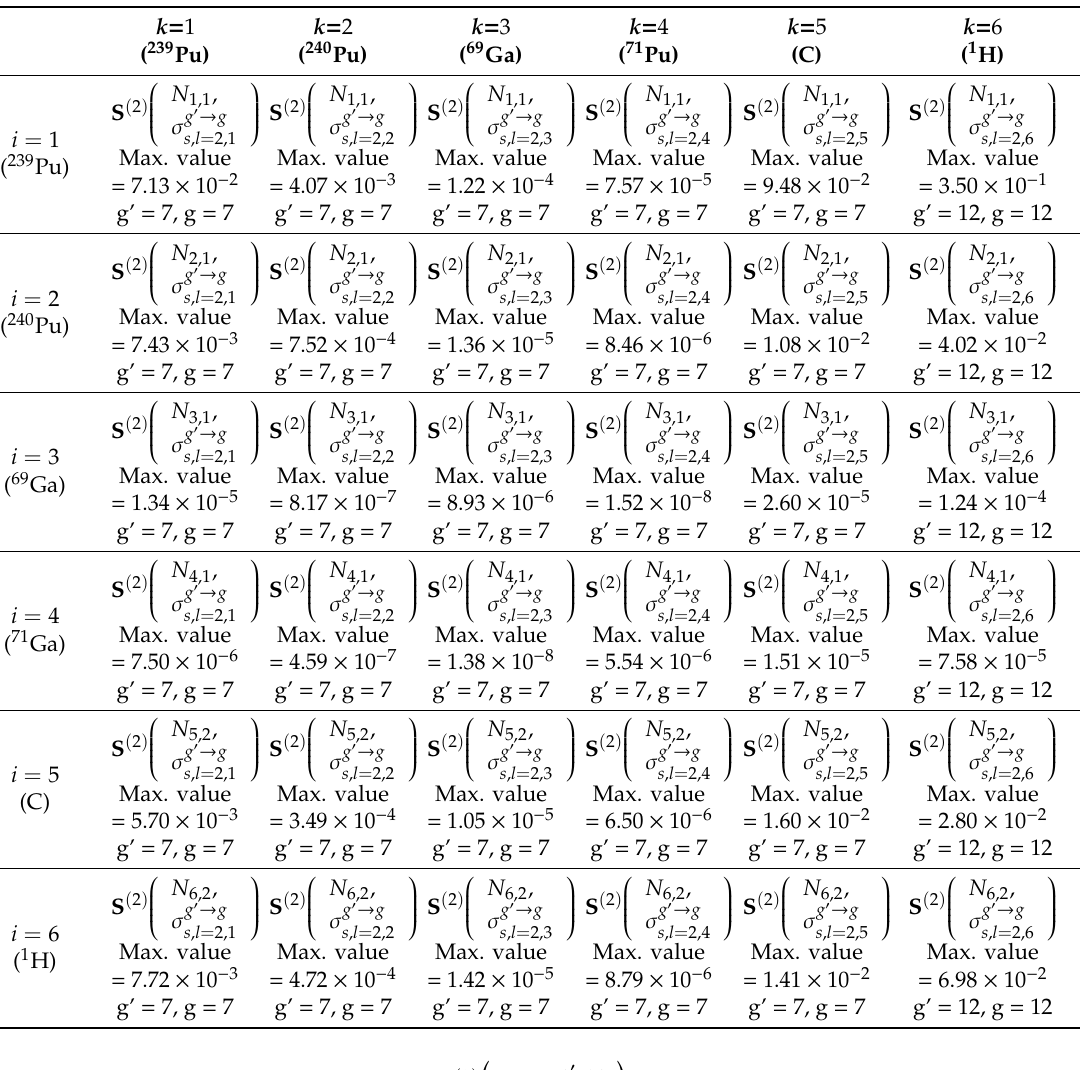
Table 17. Summary presentation of the matrix S ( 2 ) the leakage response with respect to the isotopic number densities and the 2nd-order ( l = 2 ) scattering cross sections for all